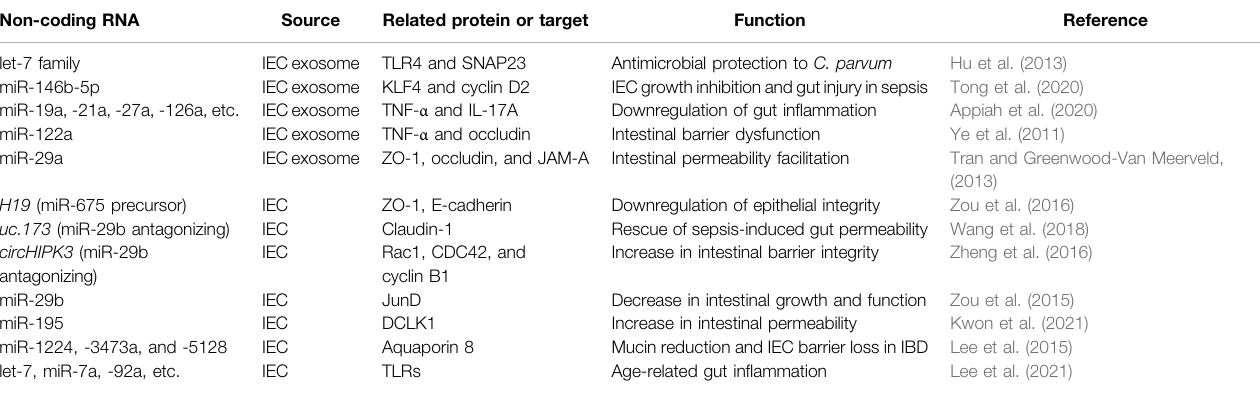
TABLE 1 | IEC- or IEC exosome-derived noncoding RNAs and their functions discussed in this review. Non-coding